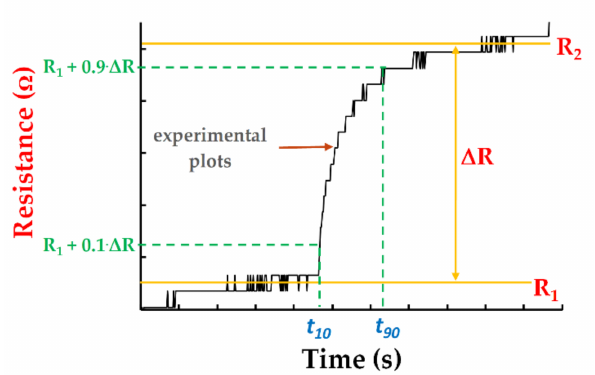
Figure 13. Example for calculation of response time.